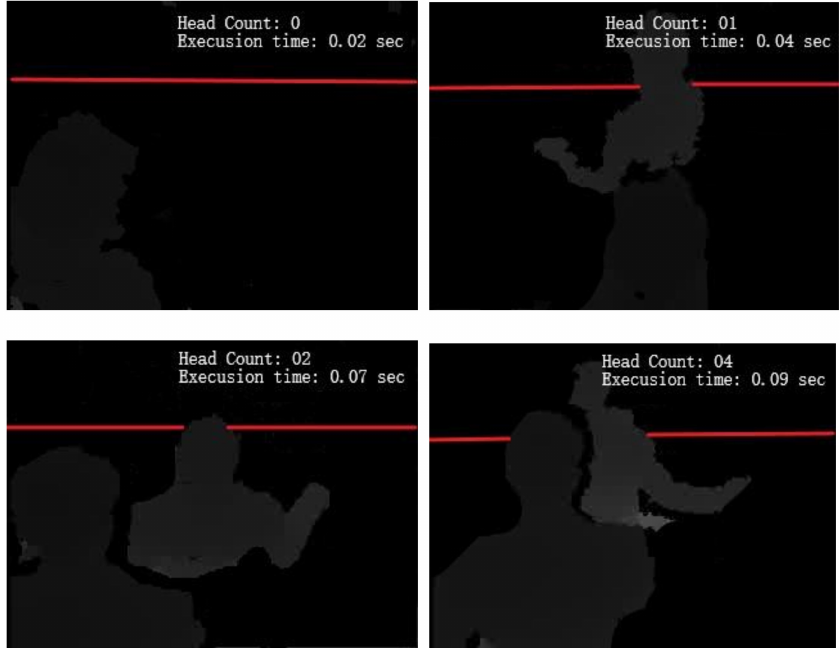
Figure 11. Results obtained for head counting using cross-line judgment over the PCDS dataset.